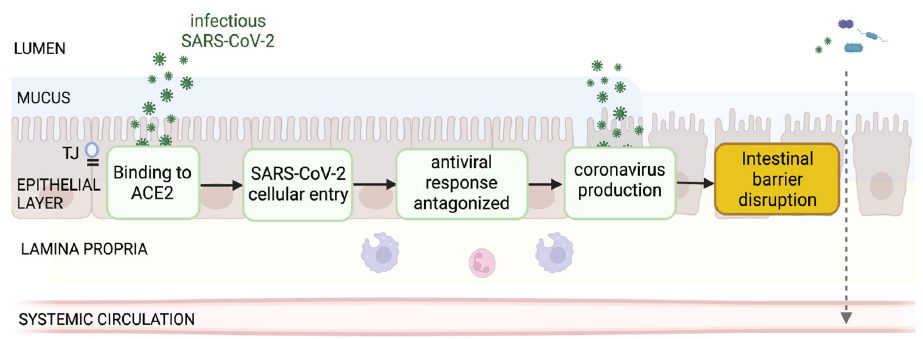
Figure 2. Pathway depicting the sequence of events for SARS ‐ CoV ‐ 2 enteric production impairing the intestinal barrier (AOP422). Evidence is evaluated in the present work to assess the likelihood of occurrence.